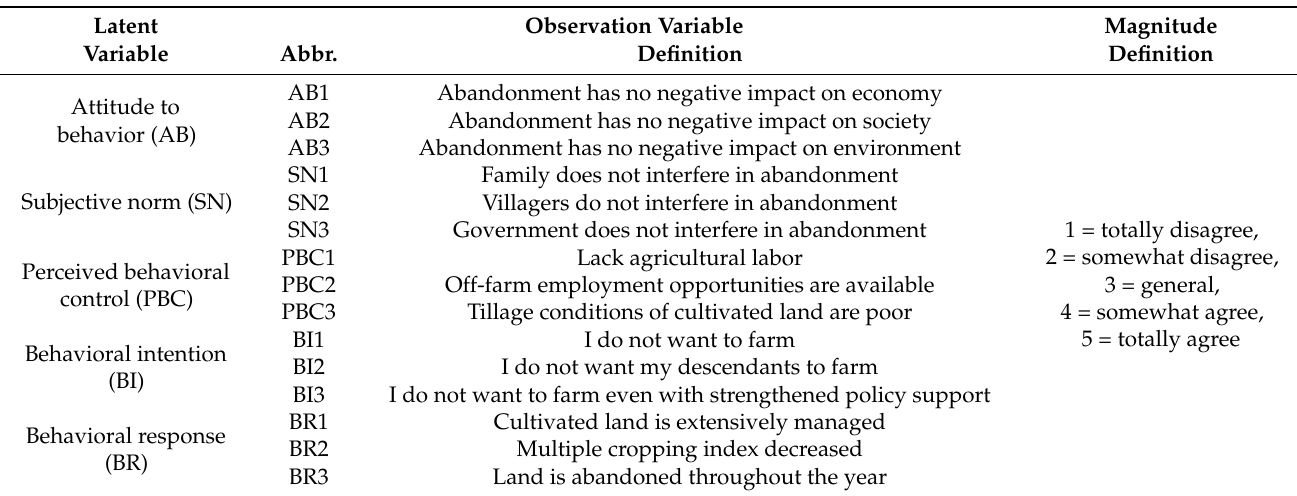
Table 1. Selection and definition of